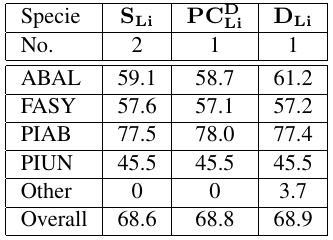
Table 6: F1-scores of feature fusion from three LiDAR sets by stacking a number of features (No.) to the reference set described in Table